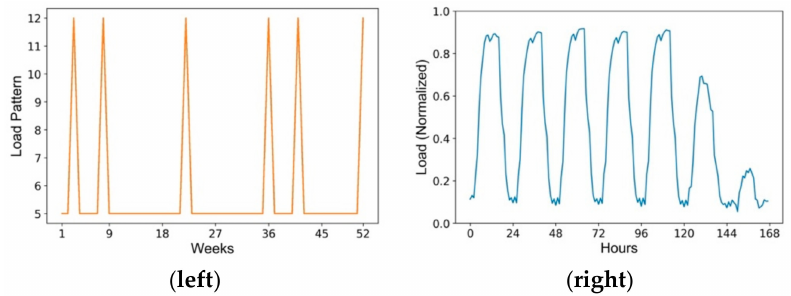
Figure 11. Typical user behaviors of Outpatient ( left ) and corresponding load patterns in short-term ( right